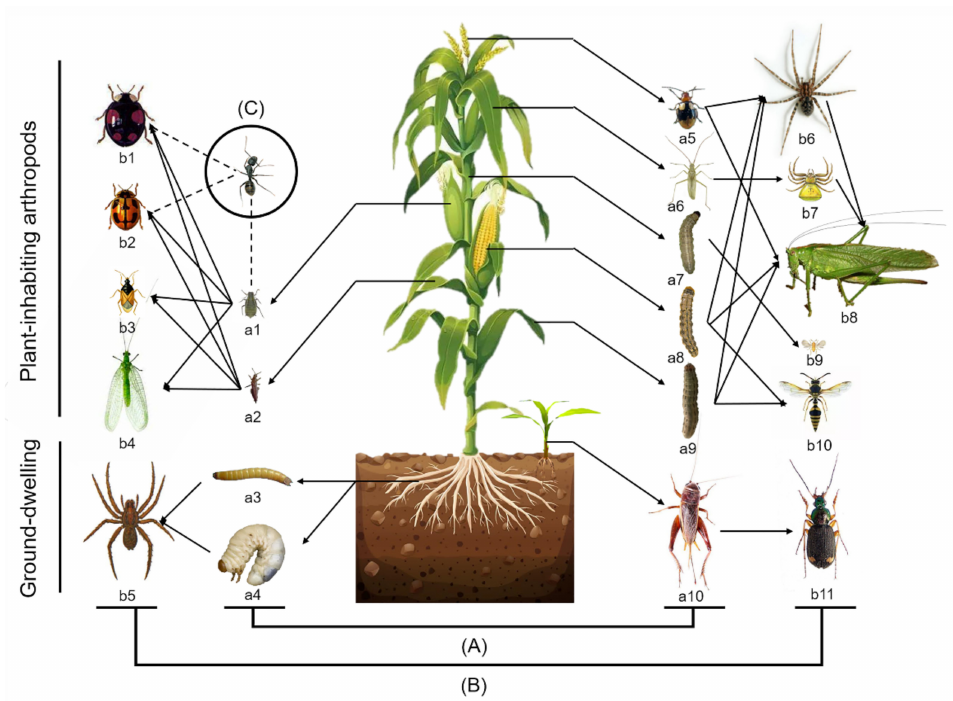
Figure 1. Important arthropod species in the food webs in maize field in Yitong, northeast China. ( A ) The herbivores included Rhopalosiphum maidis ( a1 ), Haplothrips aculeatus ( a2 ), Monolepta hiero- glyphica ( a5 ), Trigonotylus ruficornis ( a6 ), Ostrinia furnacalis ( a7 ), Helicoverpa armigera ( a8 ), Mythimna separata ( a9 ), eating leaves and buds, and wireworms (Coleoptera: Elateridae) ( a3 ), Anomala corpulenta ( a4 ), Teleogryllus emma ( a10 ) , eating roots and stems; ( B ) the predators and parasites were Harmo- nia axyridis ( b1 ), Propylaea japonica ( b2 ), Orius sauteri ( b3 ), Chrysopa pallen ( b4 ) , Pirata subpiraticus ( b5 ) , funnel-web spiders (Araneida: Agelenidae) ( b6 ), Misumenops tricupiuatus ( b7 ), Tettigonia chi- nensis ( b8 ), Trichogramma ostriniae ( b9 ), potter wasps (Hymenoptera: Vespidae) ( b10 ) and Chlaenius bioculatus ( b11 ); ( C ) another related arthropod was Camponotus japionicus . The solid arrows indicate predation relationships; the dashed arrows indicate regulatory